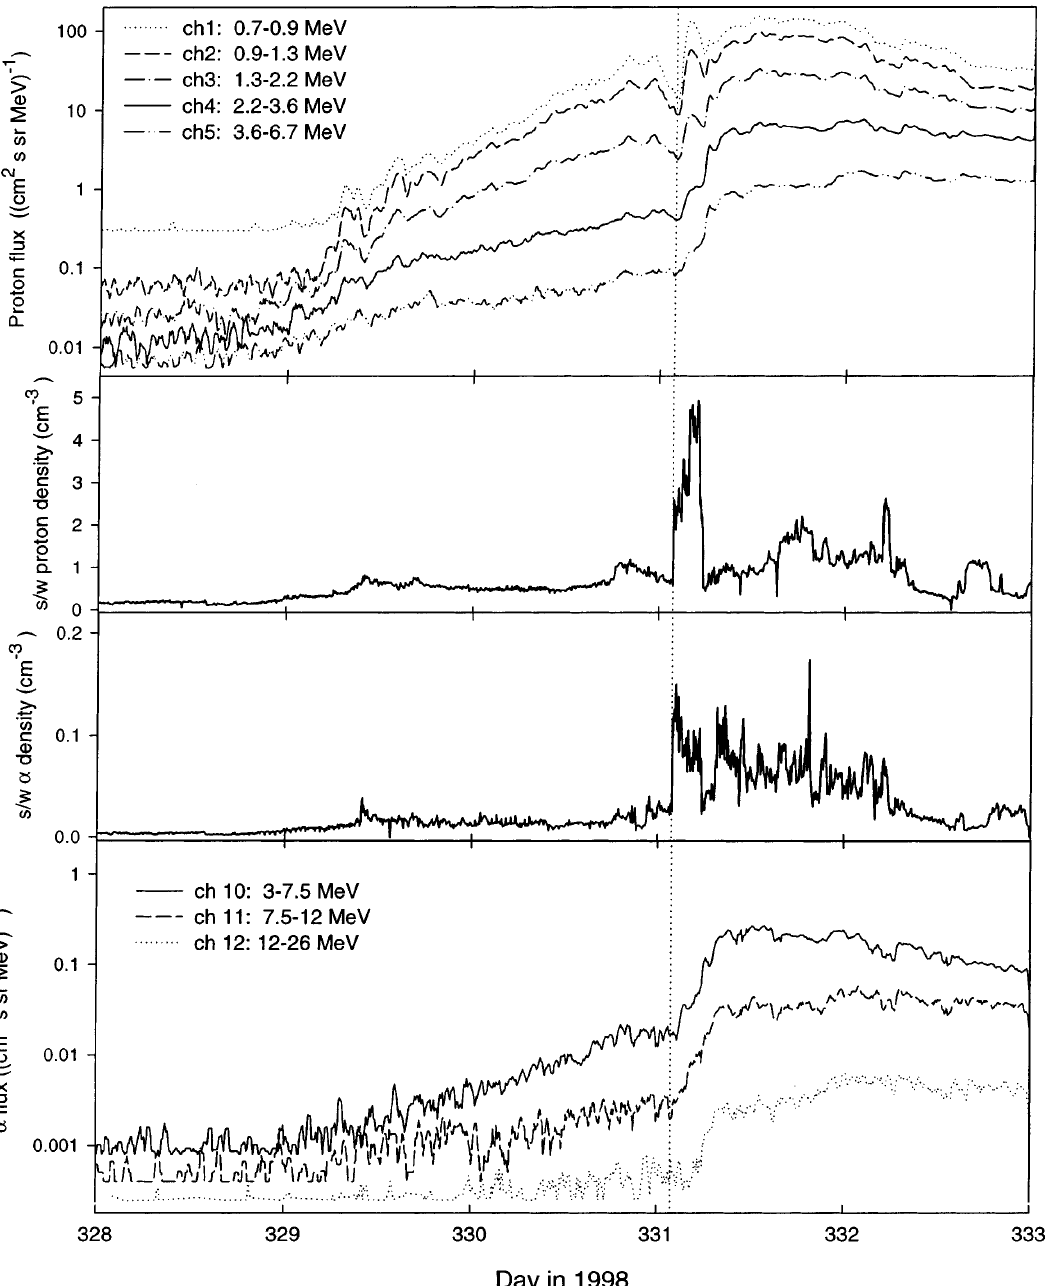
Fig. 2. Onset phase of the November 1998 event. In the first panel ATs spin-averaged proton fluxes for five energy channels are given. The second and third panel show the solar wind proton and a -particle